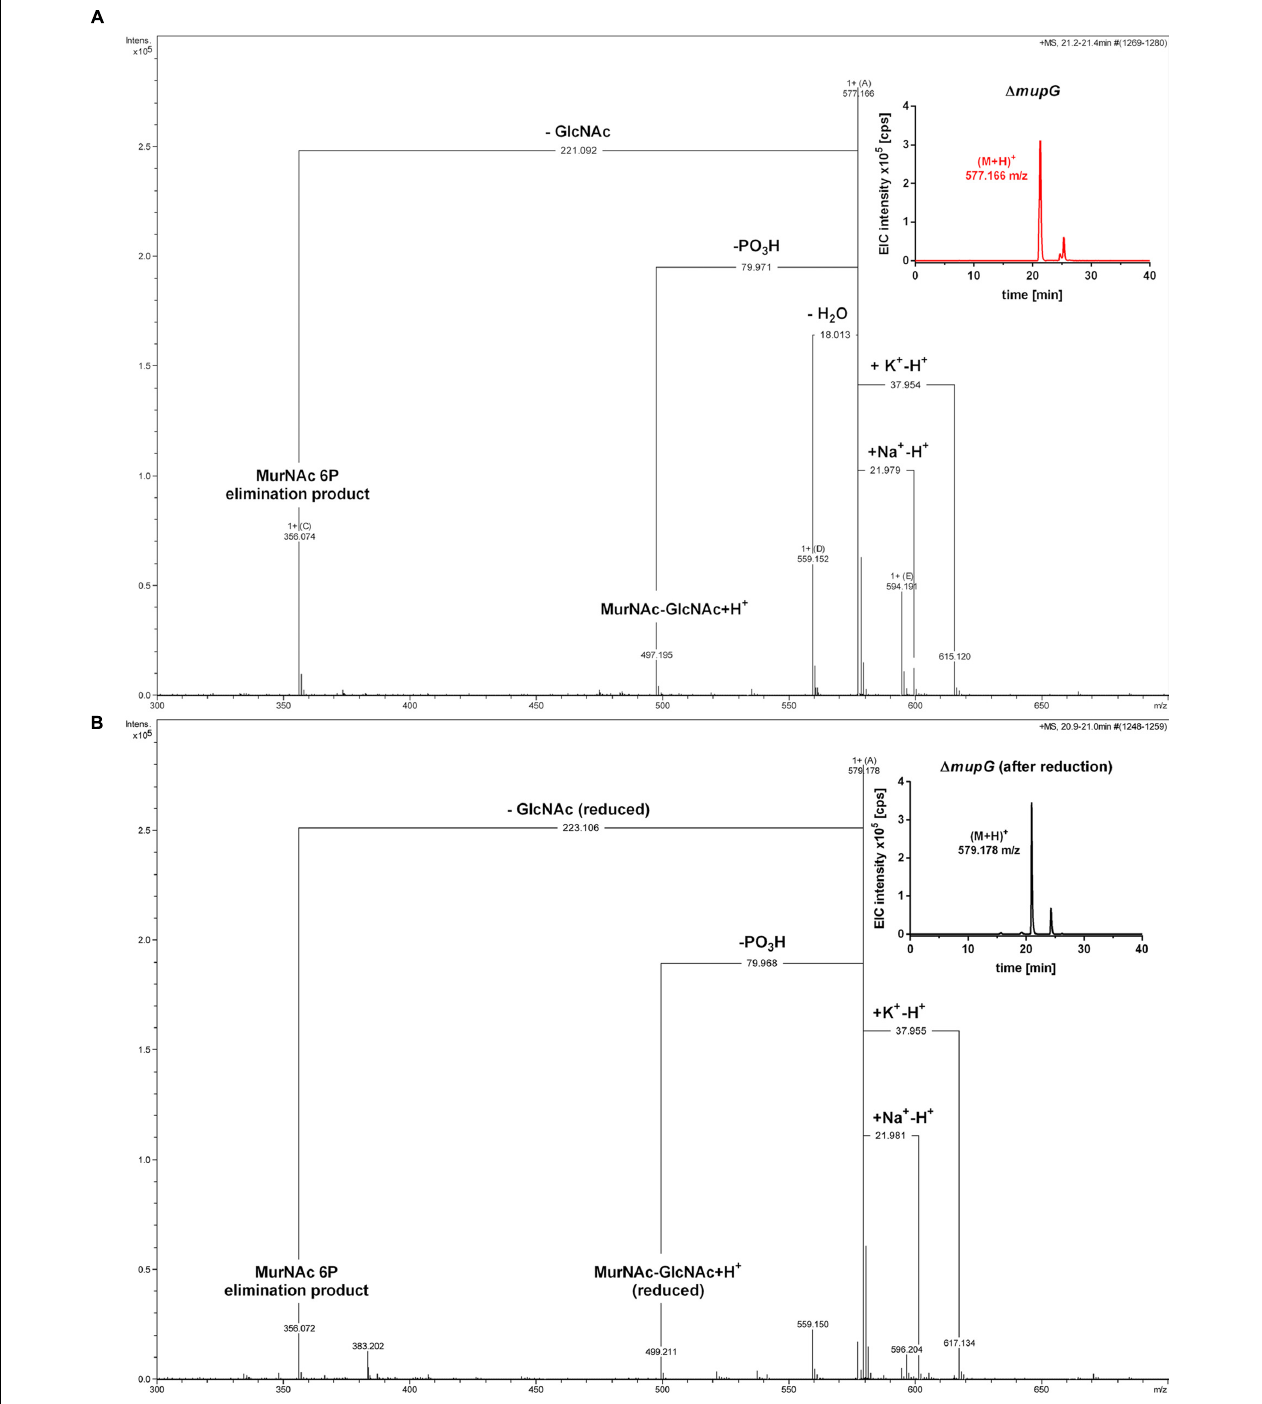
FIGURE 3 | Accumulation of MurNAc 6P-GlcNAc in (cid:49) mupG cells. S. aureus (cid:49) mupG was grown in LB medium to stationary phase (24 h). Acetone extracts of the cytosolic fractions were analyzed by LC-MS in positive ion-mode, before (A) and after (B) NaBH 4 reduction. (A) Shown are the fragmentation patterns obtained by in-source decay of the compound that accumulates specifically in (cid:49) mupG mutant cells and eluates at a retention time of 21.2–21.4 min, represented as extracted ion chromatogram with an observed mass of (M+H) + = 577.166 m/z (EIC × 10 5 counts per s [cps], upper right corner). Representative mass spectra from three biological replicates are illustrated. (B) Shown are the fragmentation patterns after reduction of the sample with NaBH 4 , which results in the formation of a new compound that elutes at 21.0 min, represented by an EIC with an observed mass of (M+H) + = 579.178 m/z (upper right corner). The mass spectra fragmentation patterns of both compounds were presented in Compass DataAnalysis program (Bruker) from 300 to 700 m/z. The obtained fragmentation pattern indicated that the substrate for MupG is MurNAc 6P-GlcNAc.